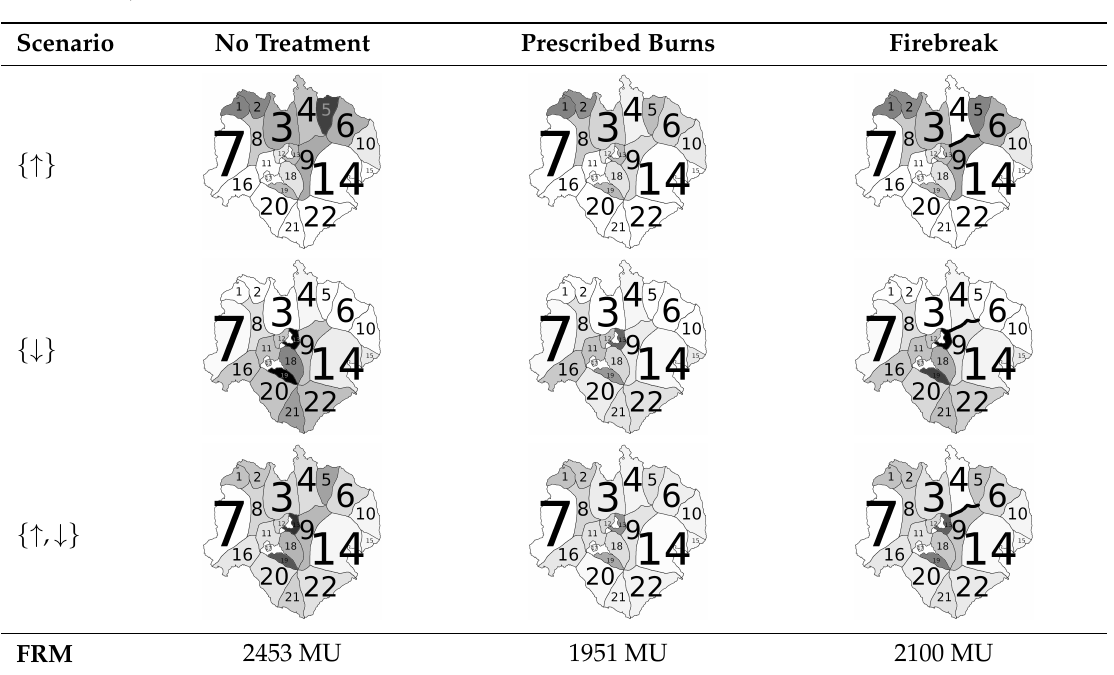
Table 5. FRM with different scenario set and forestry treatments: no treatment, prescribed burn in sector 9, location of firebreak between sector 4 and